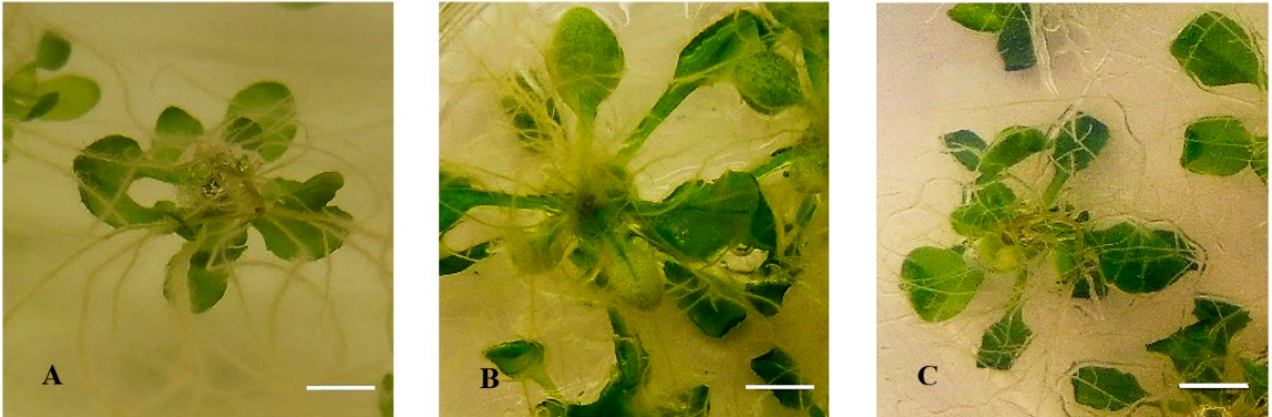
Figure 5. The percentages of apoplastic water and air related to the total volume of the apoplast in Arabidopsis thaliana less-lignin-mutant ref3-1 and ref3-3 seedlings after 14 days of culture on 0.7% ( w/v ) Micro-agar, 0.4% ( w/v ) gelrite and 0.4% gelrite ( w/v ) + 100 µM p- coumaric acid. Different letters indicate significant differences between means at α = 0.05 level.